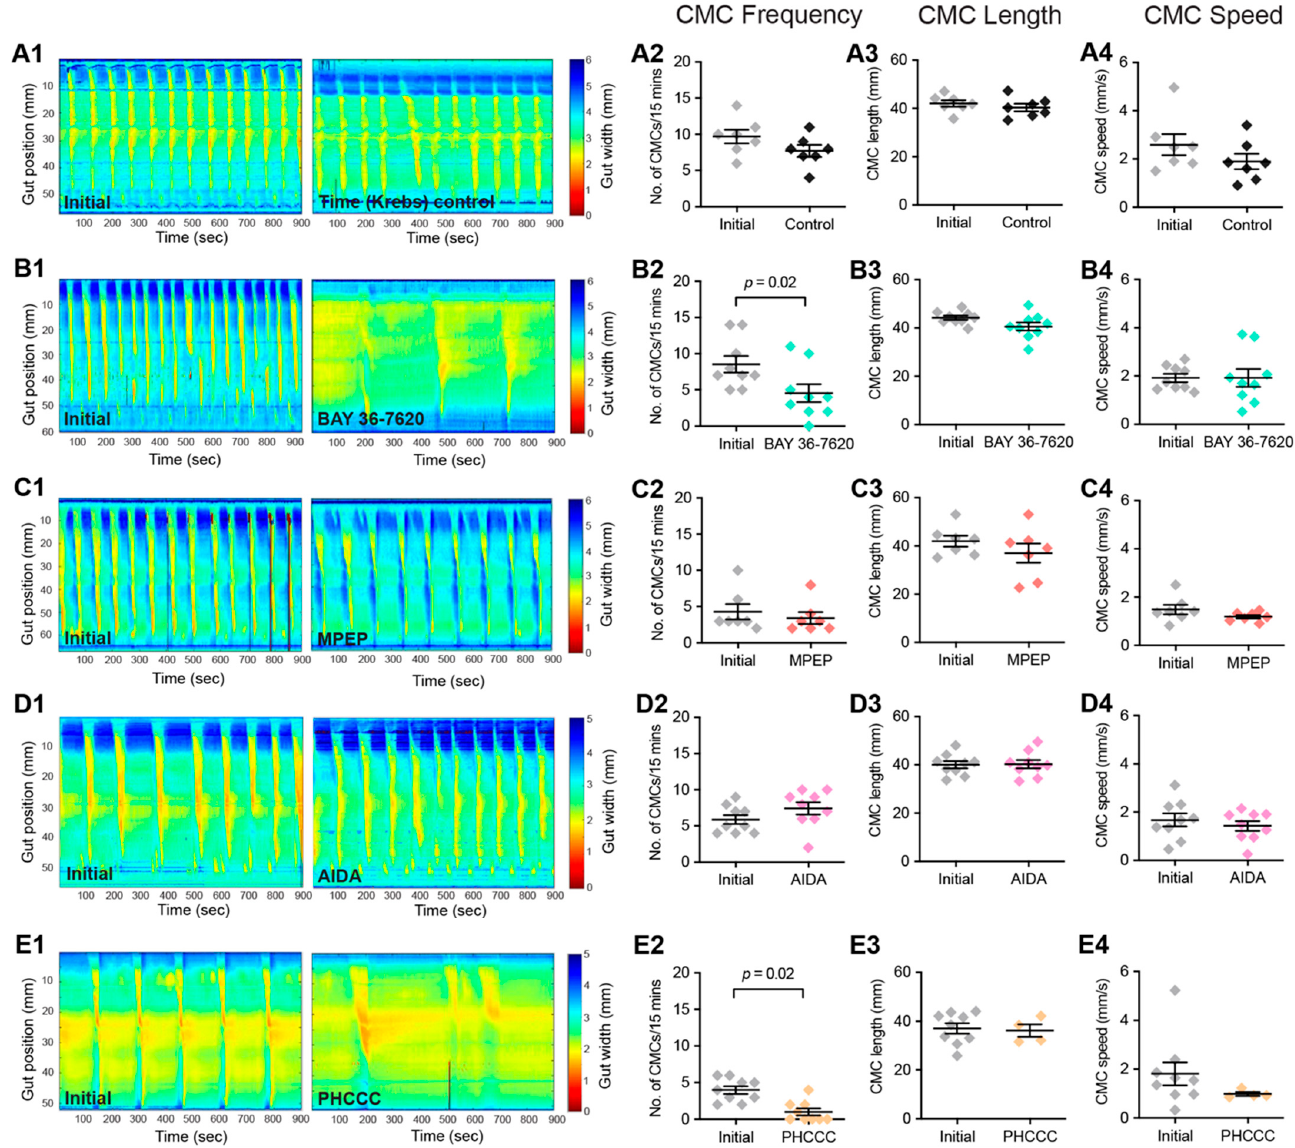
Figure 6. Antagonists of Group-I mGlu receptors reduce colonic motility. Spatiotemporal heat maps were generated from video recordings of colonic contractions ex vivo, showing changes in colonic diameter over time. The contractions in these maps were compared between Initial baseline recordings and the different drug conditions: ( A ) Time control, ( B ) BAY 36-7620 (10 µM), ( C ) MPEP (10 µM), ( D ) AIDA (500 µM), and ( E ) PHCCC (30 µM). ( A2 – A4 ) No significant difference in CMC frequency, length, or speed was observed during time control experiments. ( B2 – B4 ) In the presence of BAY 36-7620, a significant decrease in CMC frequency was observed (Control: 8 ± 1 CMCs/15 min; BAY 36-7620: 5 ± 1 CMCs/15 min, n = 9, p = 0.01); however, no difference was observed in ( A3 ) CMC length or ( A4 ) CMC speed. ( C2 – C4 ) MPEP had no effect on CMC frequency, length, or speed.